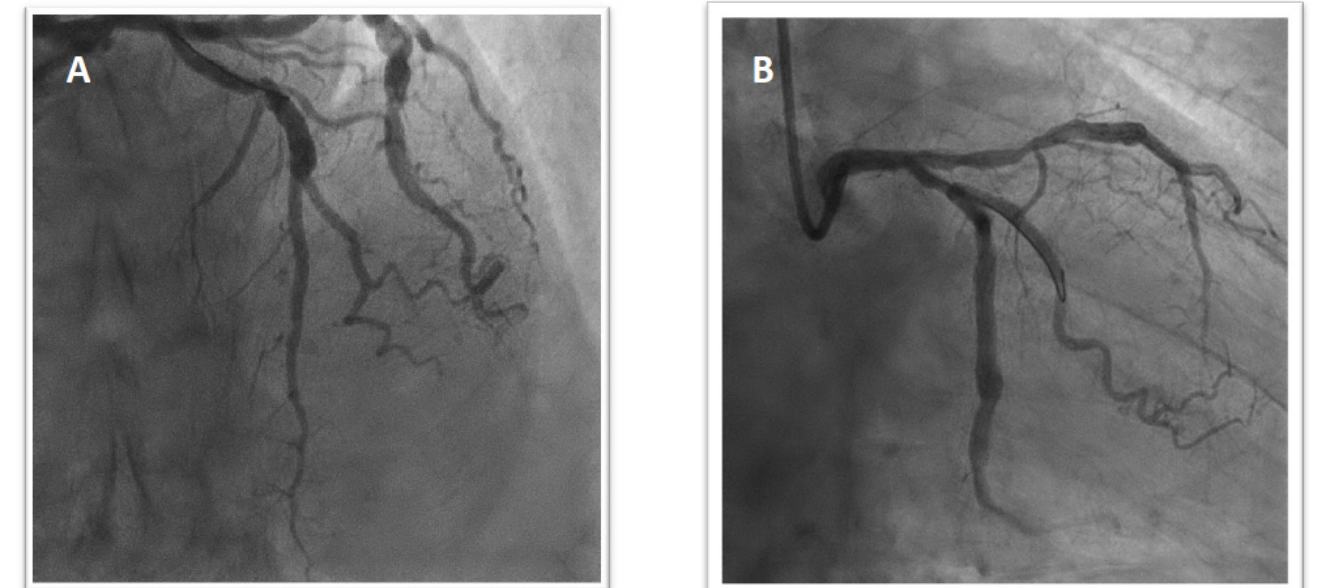
Figure 2. Final result after the first intervention with the implantation of two polymer-free DES on the mid-LAD and second diagonal branch (T stent technique; 2.75 × 24 mm and 2.25 × 14 mm) ( A ). Final result after the second intervention with implantation of a DES in the proximal obtuse marginal artery (2.5 × 25 mm) ( B ).